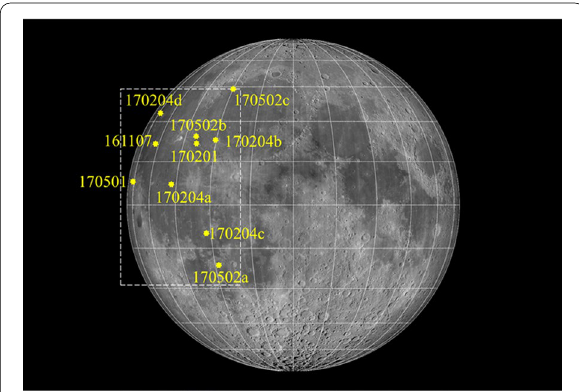
Fig. 7 Locations of the ten lunar impact flash candidates. They were observed at the University of Electro-Communications (UEC) in Tokyo, Japan. The candidates are named after dates, e.g., one observed on Nov. 7, 2016 (UT) is named “161107”. The dashed rectangular shows the size and the approximate position of the field of view in our observations. The lunar image was obtained by using the Virtual Moon Atlas